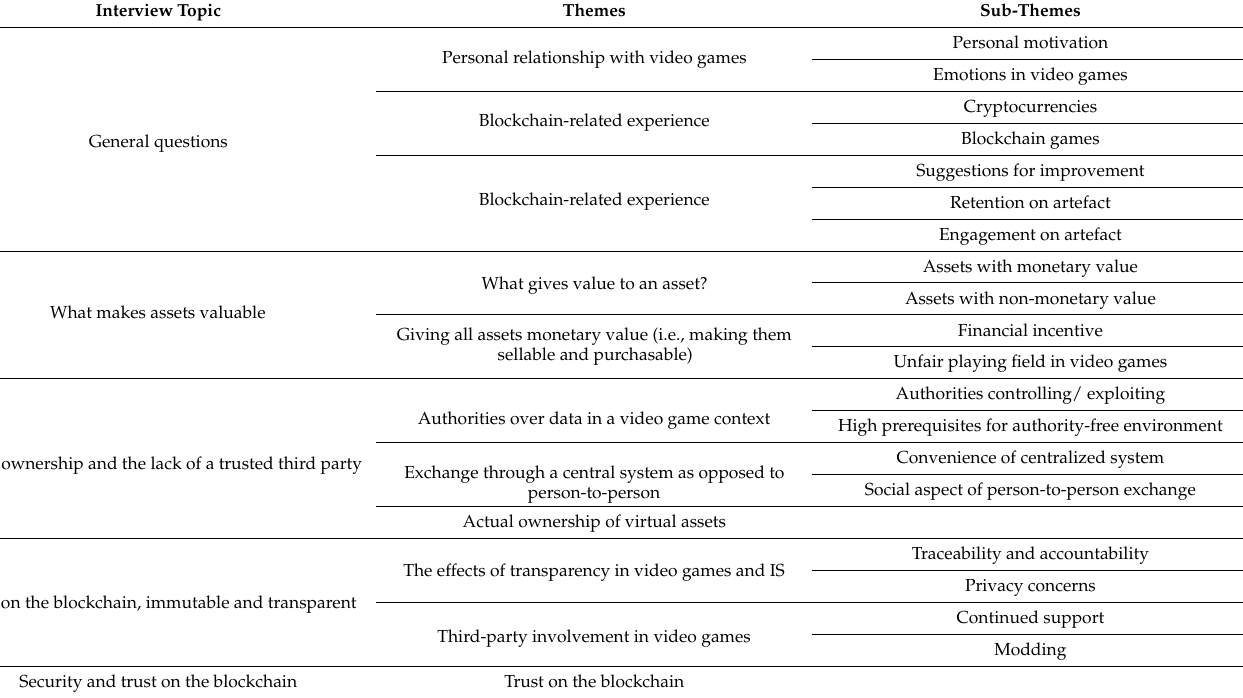
Table 4. The interview data is from the master’s thesis of Jesse Nyyssölä [30]. Table 4. Interview topics and corresponding themes with